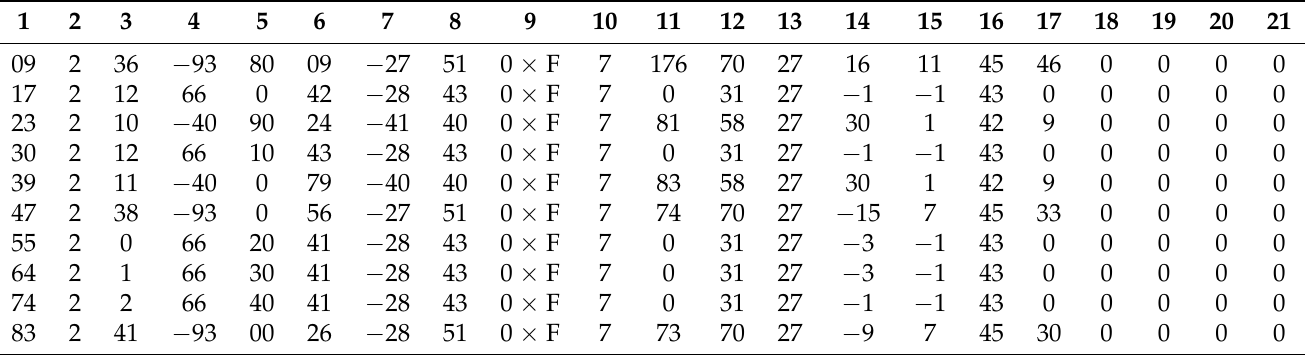
Table 3. Sample records for BSM